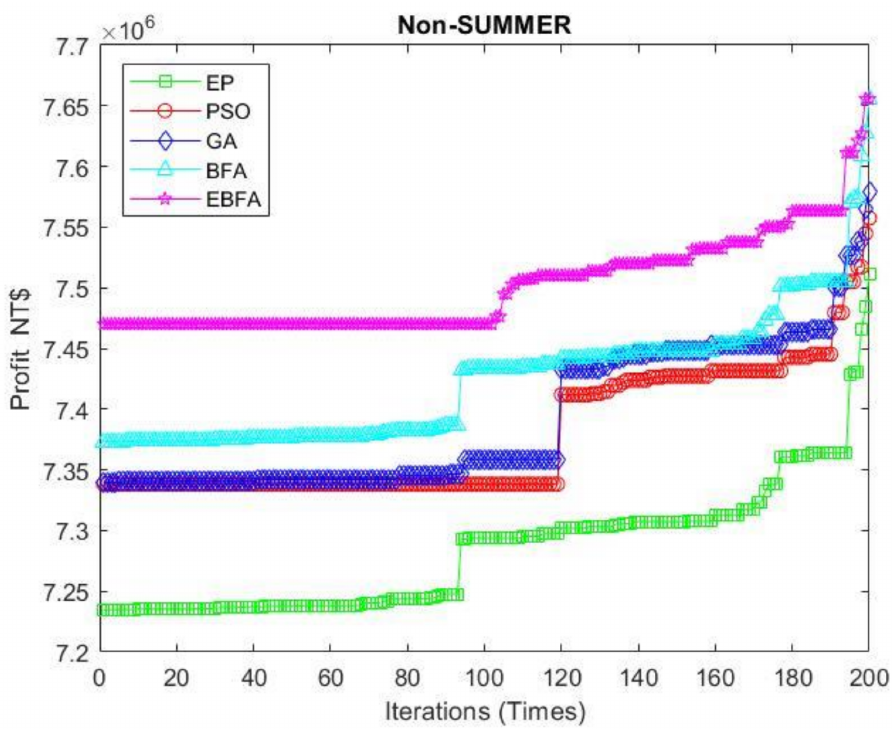
Figure 13. The convergence characteristics of EP, GA, PSO, BFA, and EBFA in